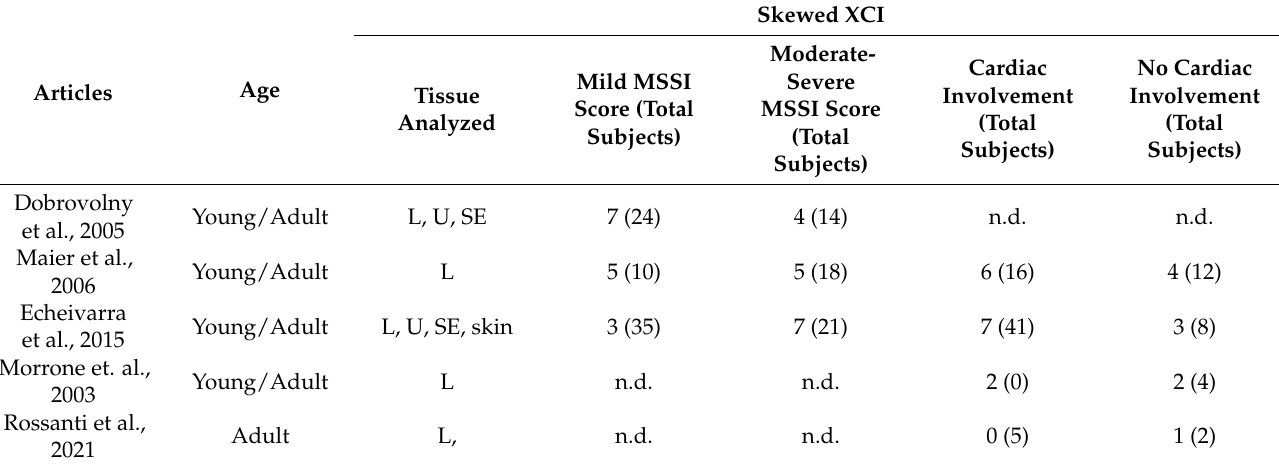
Figure 3. Flow chart. Table 1. Results of studies on the XCI in Fabry carriers.